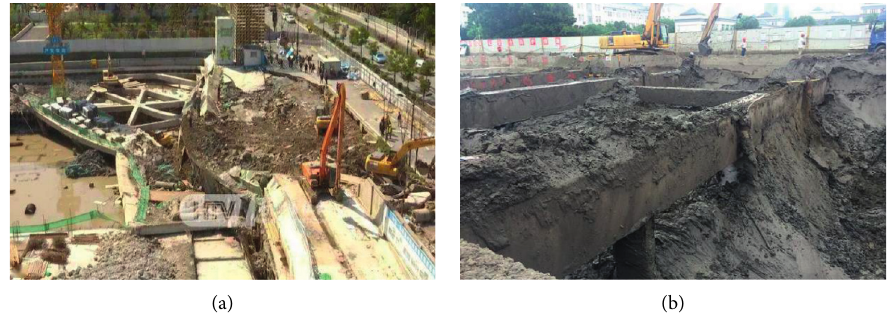
Figure 1: Foundation pit accidents: (a) foundation pit collapse and (b) the sudden surge of foundation.